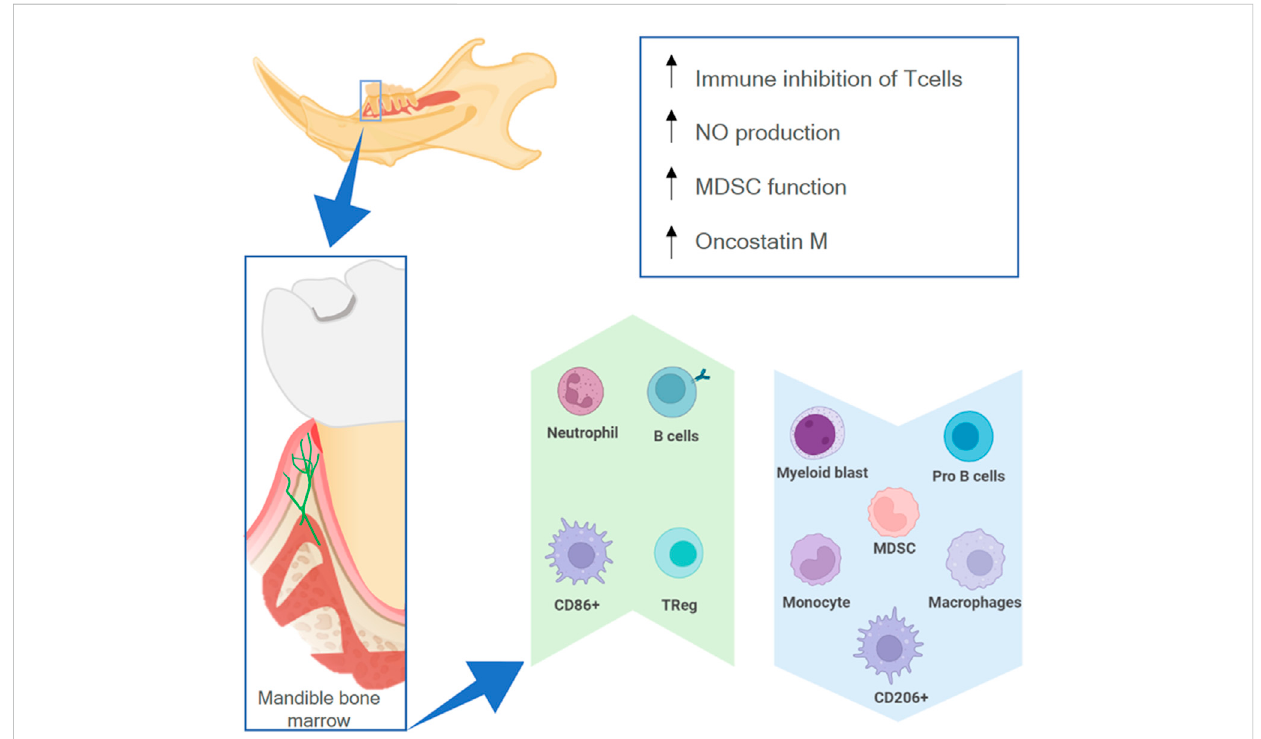
FIGURE 6 The osteoimmune environment in the mandible. The high permeability of the oral mucosa allows external antigens to have contact with the mandibularmarrow(lowerbox),resultinginahigher expression (greenupwards arrow)orlowerexpression(bluedownwardsarrow)ofdifferentimmune cells, as well as higher activity of speci fi c processes (upper